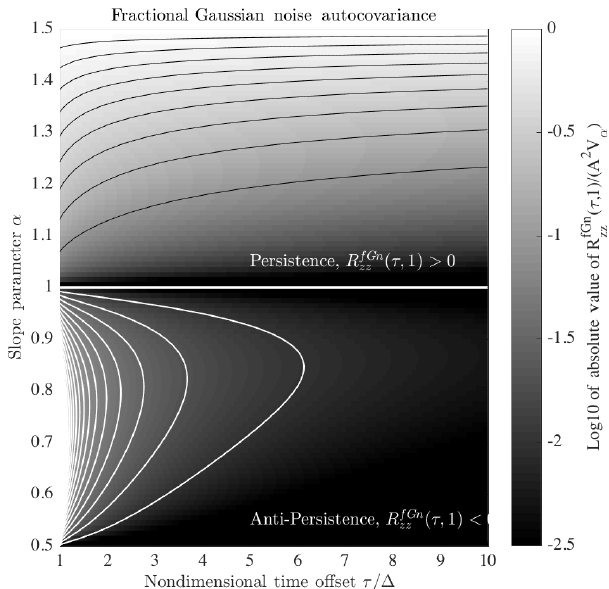
Figure F1. The fractional Gaussian noise autocovariance function R fGn ( e τ) , as defined in Eq. (F4), here normalized by dividing by zz, 1 V α and A 2 . The time axis is interpreted as the normalized time = τ/(cid:49) . The shading shows log 10 of the magnitude of the normal- e τ ized autocovariance function, which obtains a maximum of unity at α = 3 / 2 for all e τ . A sign change occurs at α = 1, with positive values at higher α and negative values at lower α . Black lines are contours of positive values, with a contour interval of 0.1 beginning at zero, while thin white lines are contours of negative values with an interval of 0.01. The heavy white curve is the zero contour at α =